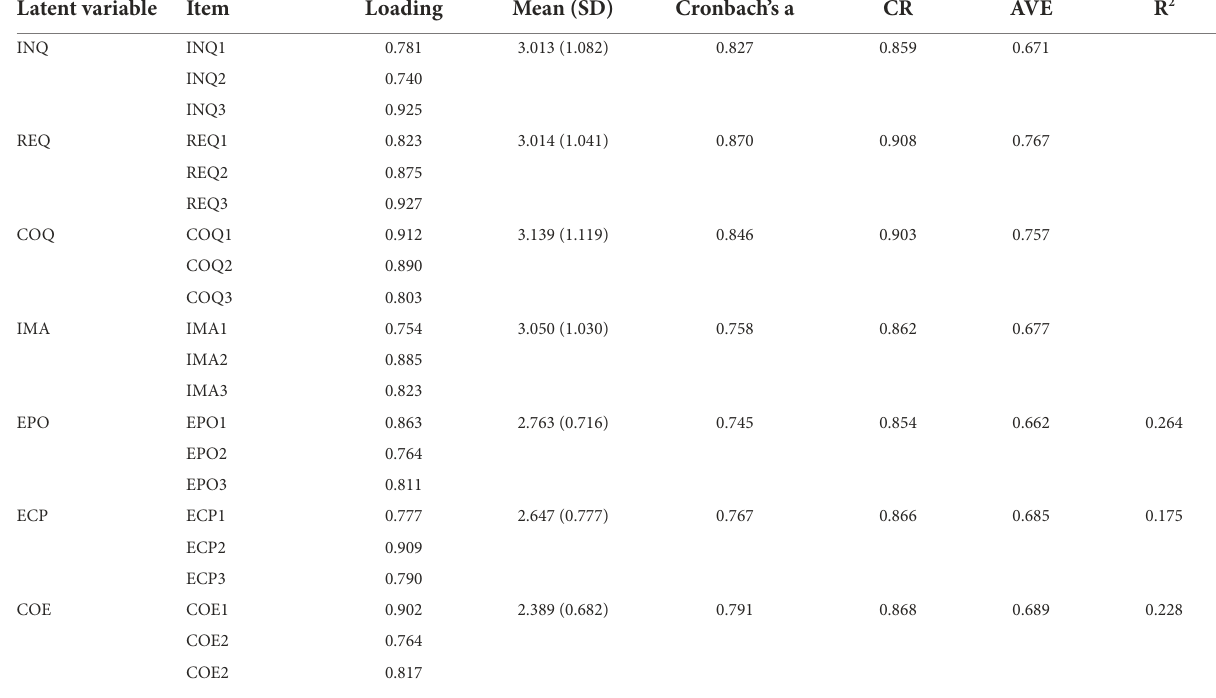
TABLE 1 Reliability and validity coefficients for constructs.